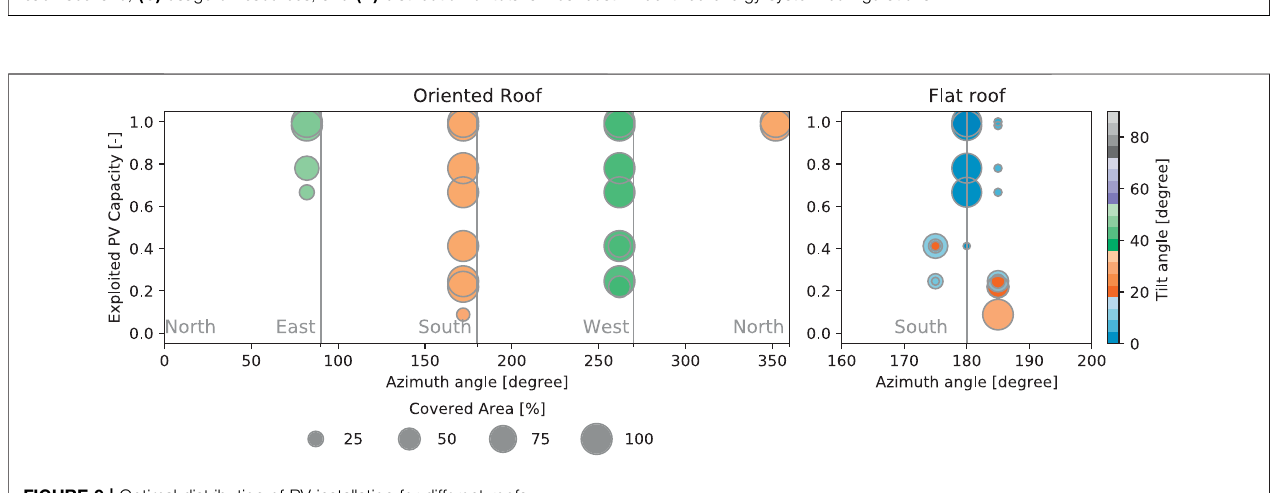
FIGURE8| ResultsofMOOofoneresidentialbuilding: (A) de fi nitionofScenariosonparetocurveforinvestmentandoperationcosts, (B) performanceindicatorfor each scenario, (C) usage of resources, and (D) distribution of total annual cost in identi fi ed energy system con fi gurations.